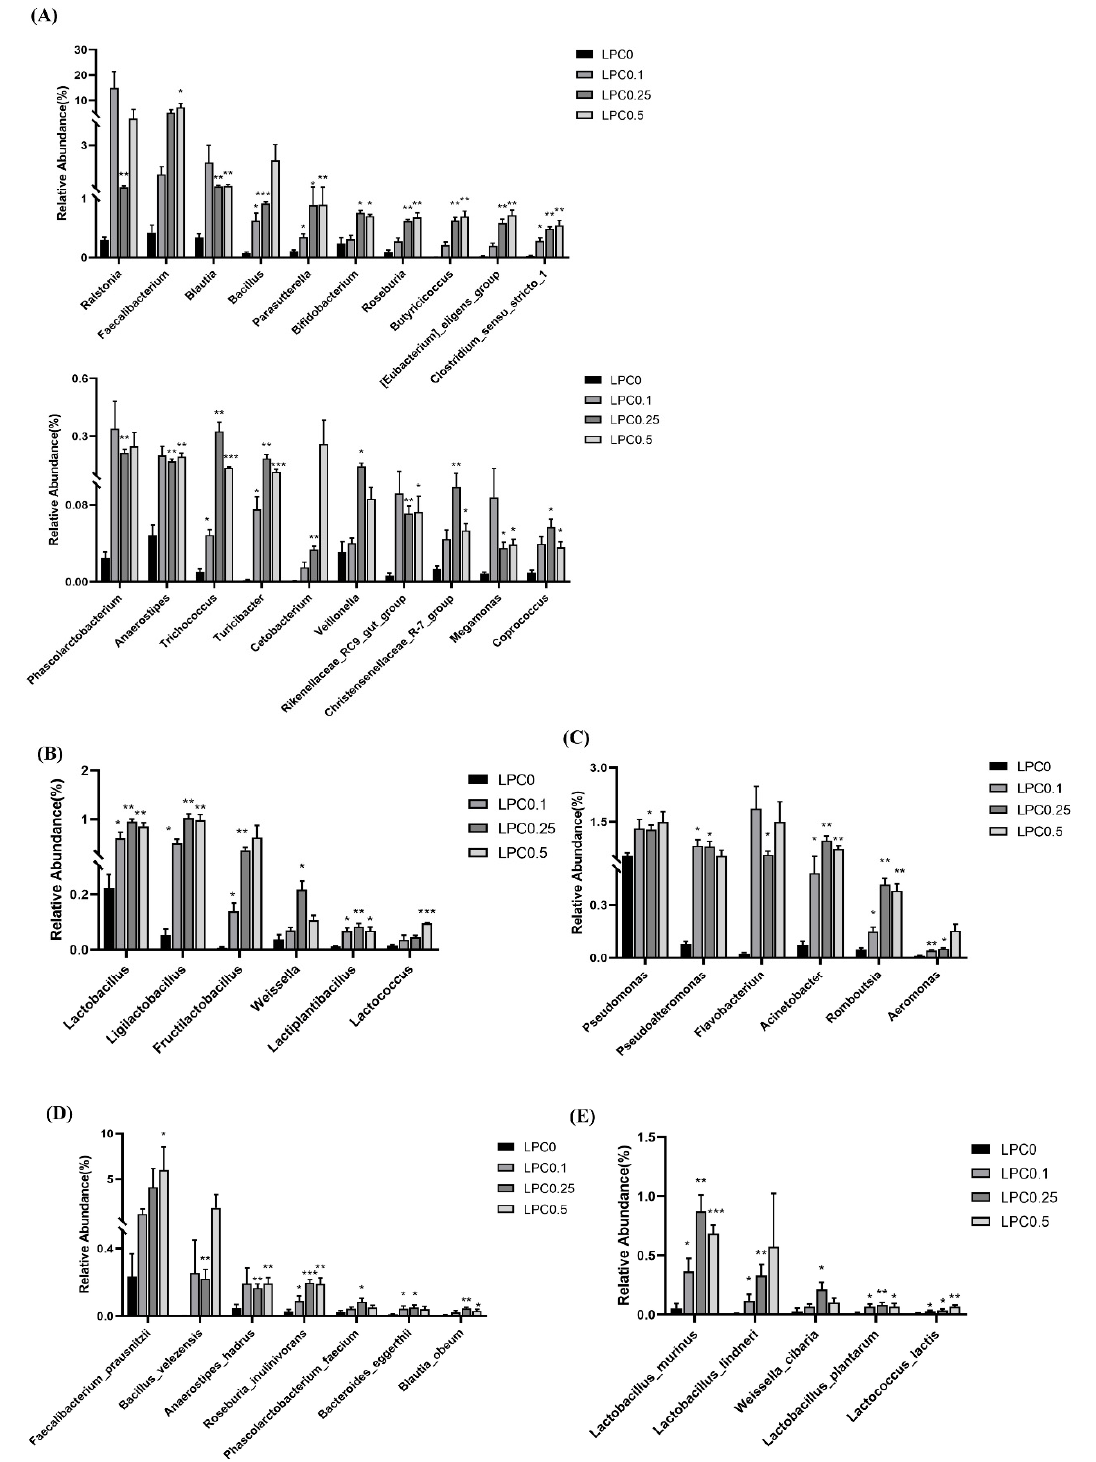
Figure 8. Metastat analysis of the intestinal microbiota communities among groups at different taxonomy. ( A – C ) Potential beneficial bacteria in intestinal microbiota at genus level. ( A ) Short-chain fatty acid producer, ( B ) Lactic acid producer, ( C ) Digestive enzyme-producing bacteria, ( D , E ) Potential beneficial bacteria in intestinal microbiota at species level. ( D ) Short-chain fatty acid producer ( E ) Lactic acid producer. * means significant difference between the LPC0 group and the LPC0.1, LPC0.25 or LPC0.5 group (* p < 0.05, ** p < 0.01, *** p <